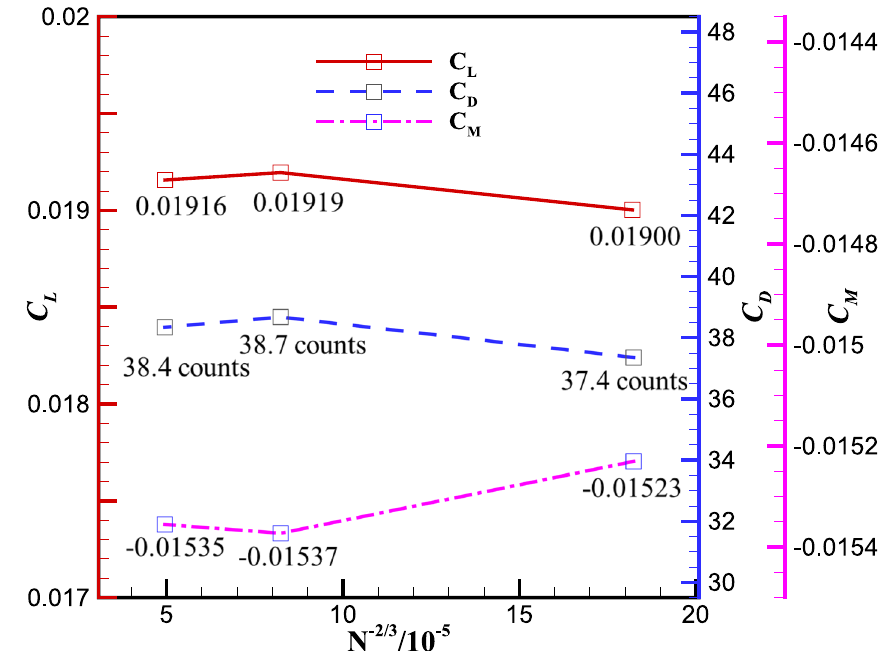
Fig. 12 Variation of the force coefficients with the mesh